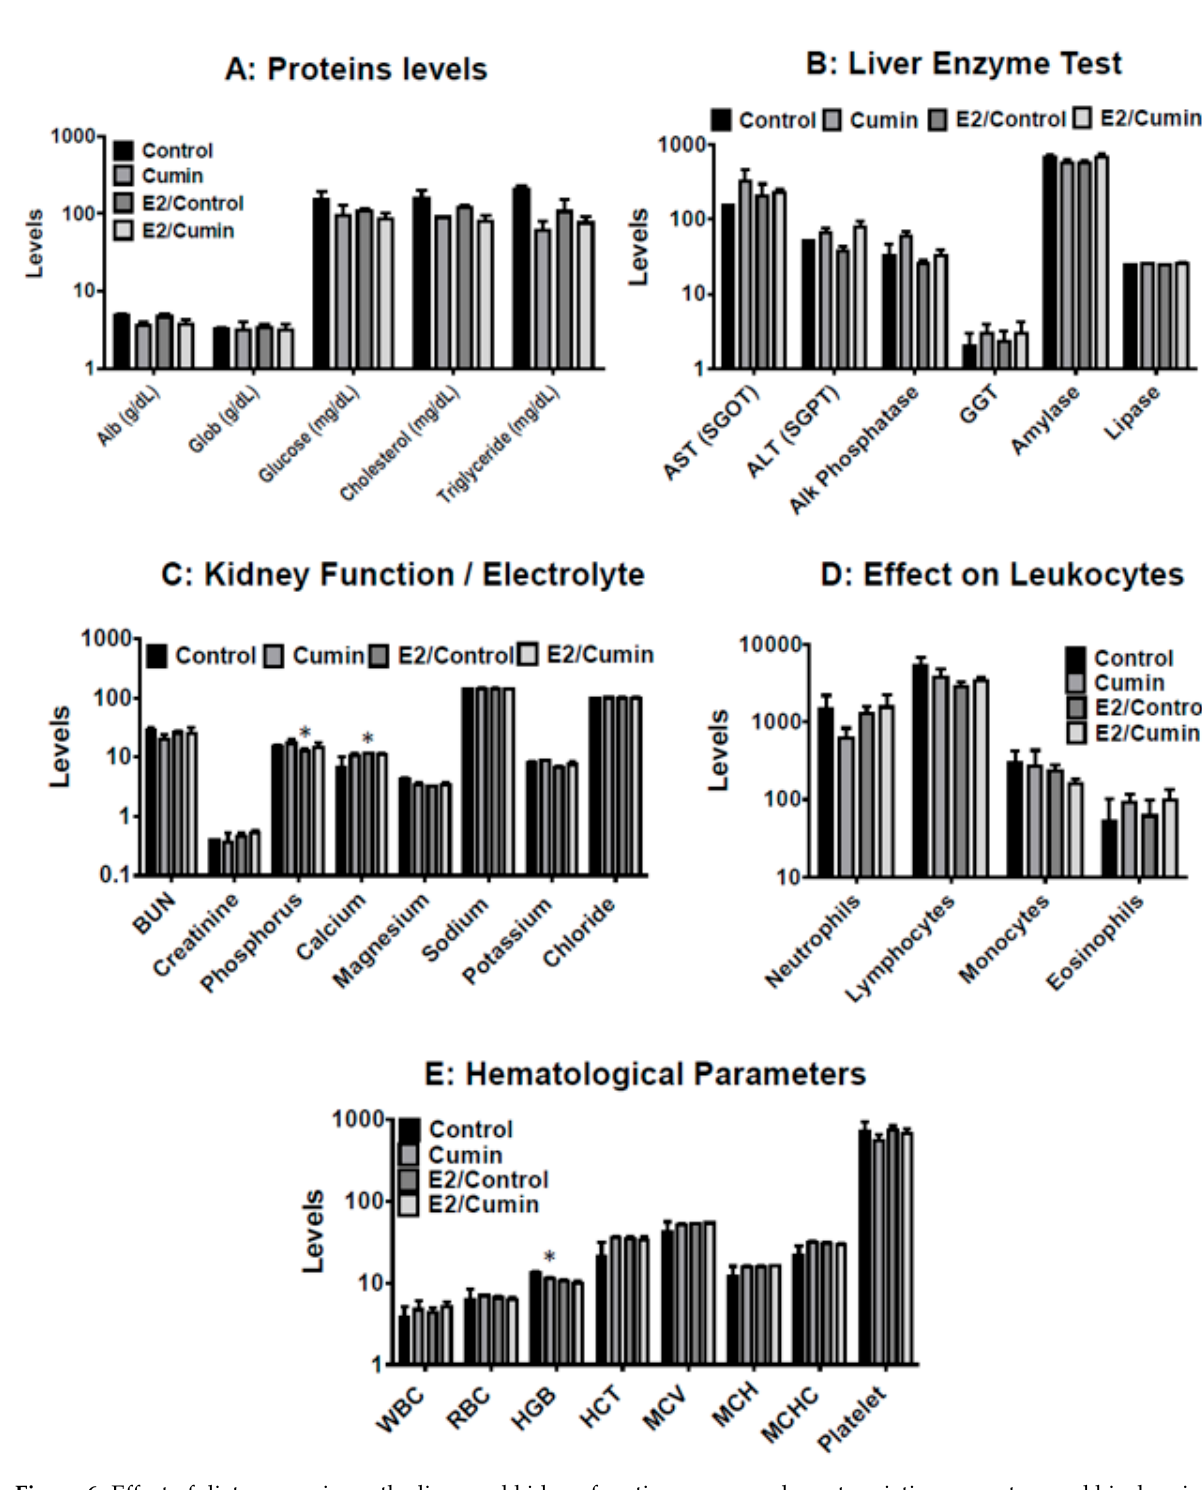
Figure 6. Effect of dietary cumin on the liver and kidney function enzymes, hematopoietic parameters and biochemical parameters in ACI rats. ACI rats (5–6 weeks old) were provided control diet (AIN 93M) or diet supplemented with cumin seed powder (7.5%, w / w ) in the absence and presence of E2 for 26 weeks. Animals were euthanized and blood plasma was analyzed for ( A ) protein levels, ( B ) liver enzyme test, ( C ) kidney functions/electrolyte, ( D ) effect on leukocytes and ( E ) hematological parameters. Data represent mean ± SD. Student’s t-test was used for statistical analysis. * p < 0.05.